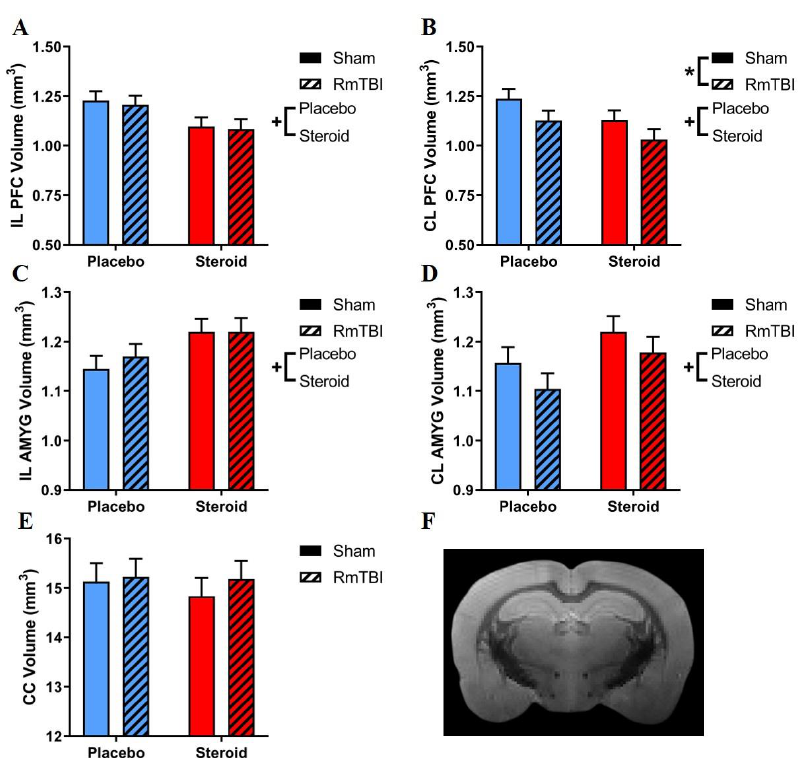
Figure 1. Bar graphs displaying MRI volumetric analysis in regions of interest. ( A ) IL PFC; main effect of steroid treatment whereby steroid groups had lesser volumes than placebo groups. ( B ) CL PFC; main effect of steroid treatment whereby steroid groups had decreased volumes compared to placebo groups; main effect of RmTBI, whereby injured animals had decreased volumes compared to sham animals. ( C ) IL AMYG; main effect of steroid treatment, whereby steroid groups had increased volumes compared to placebo groups. ( D ) CL AMYG; main effect of steroid treatment, whereby steroid groups had increased volumes compared to placebo groups. ( E ) CC; no significant effects from steroid treatment or RmTBI. ( F ) An example of an MRI image. Means ± standard error are displayed where (*) indicates a main e ff ect of RmTBI, and ( + ) indicates a main e ff ect of steroid treatment; p ≤ 0.05. MRI, magnetic resonance imaging; IL, ipsilateral; CL, contralateral; PFC, prefrontal cortex; AMYG; amygdala; CC, corpus callosum; RmTBI, repetitive mild traumatic brain